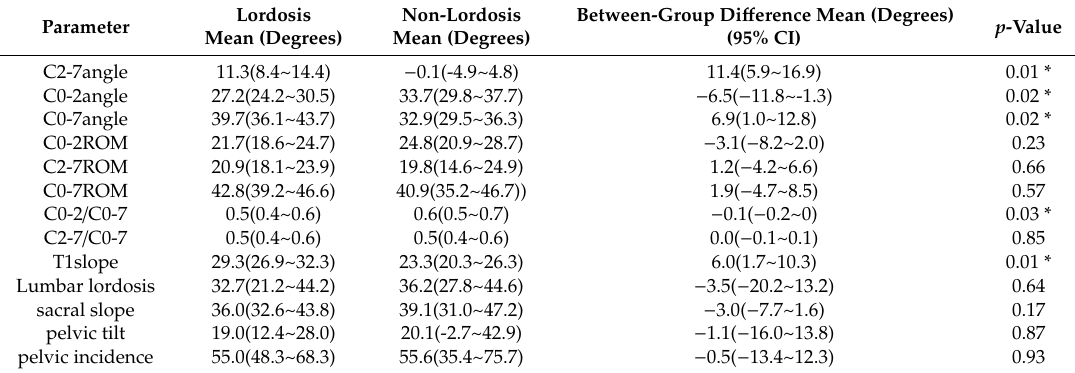
Table 4. Comparison of post-operative radiographic parameters between lordosis and non-lordosis.